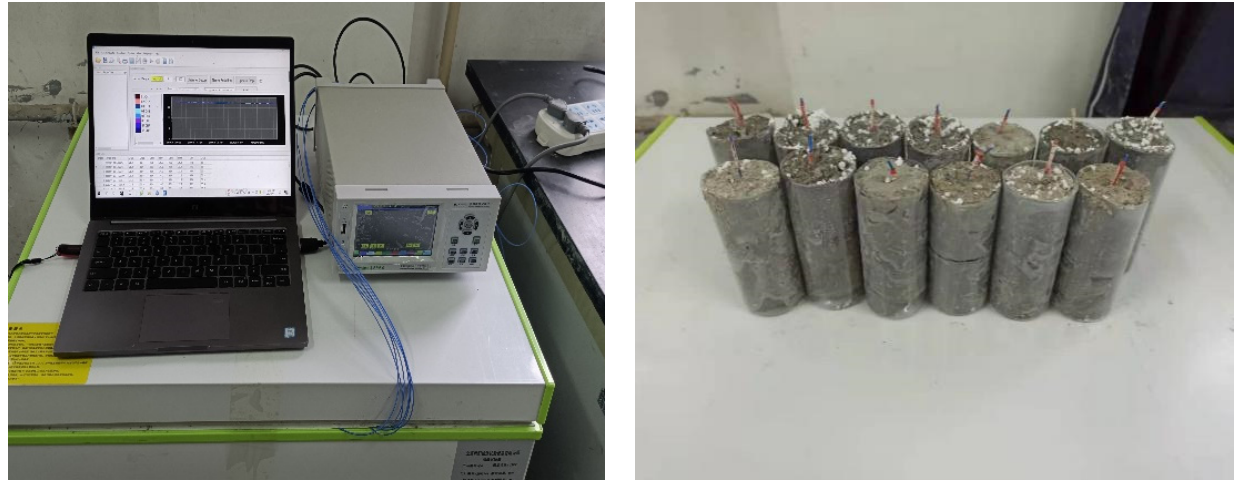
Figure 1. Hydration temperature testing device and test samples.